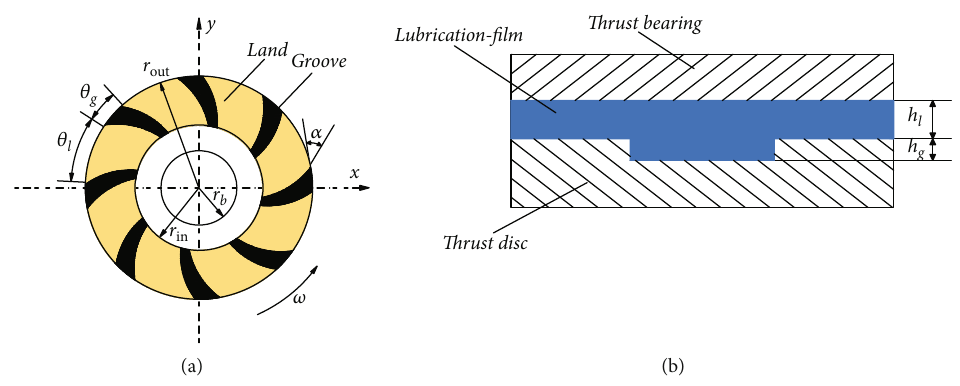
Figure 1: The schematic of spiral-grooved thrust